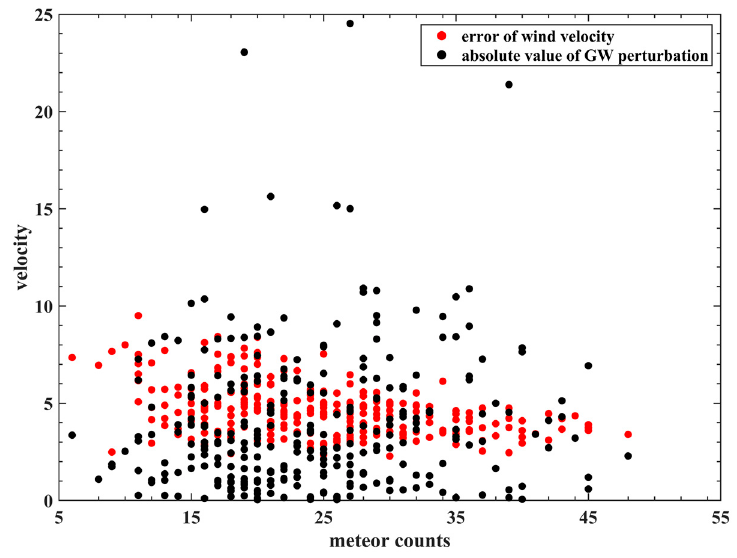
Figure 7. Comparison between error wind velocity (red dots) and absolute value of GW perturbation of 5 min wind (black dots) on day 266 in 2013.